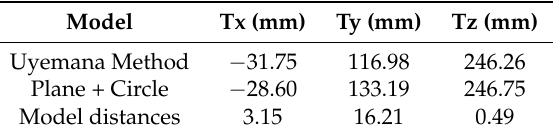
Table 6. Reference frame translation